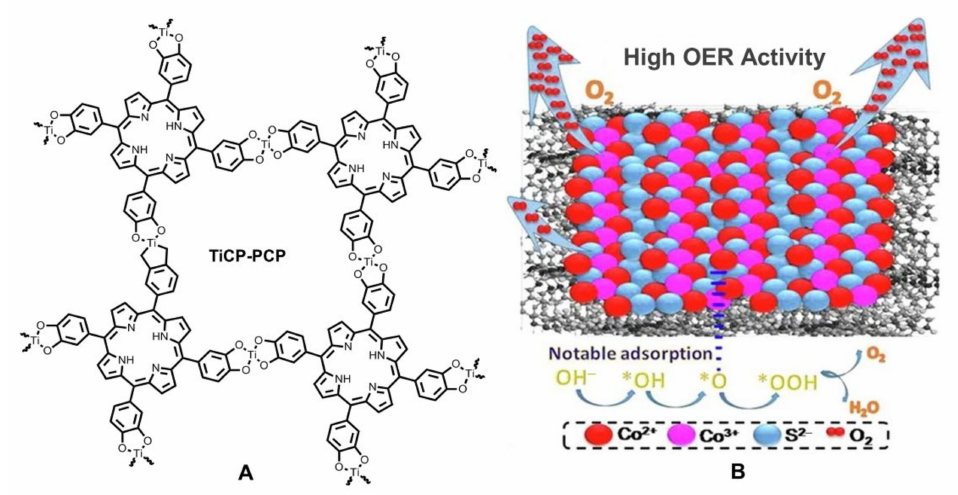
Figure 7. ( A ) Chemical structure of coordination polymer TiCP-PCP. Reproduced from ref. [60]. ( B ) Schematic representation of the catalytically active zone of 0.2TiCP-PCP@Co 1 − x S. Reprinted